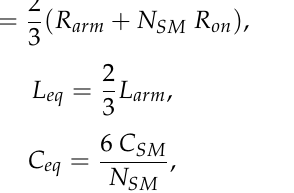
Figure 3. RLC equivalent circuit of a half-bridge MMC